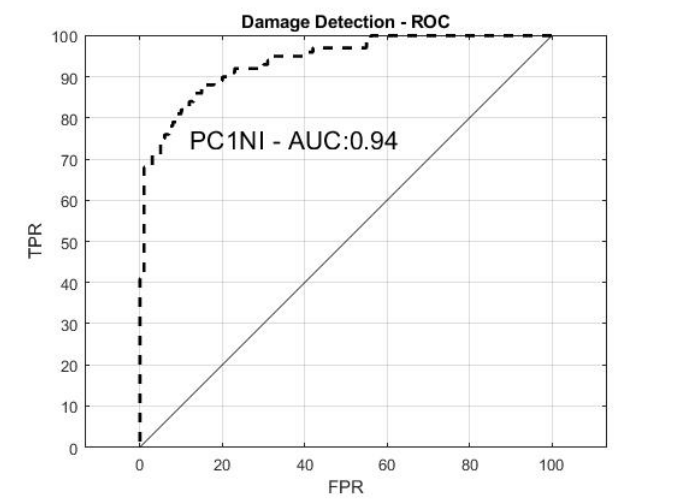
Figure 11. Evaluation of the performance of the TCM data analysis through the ROC curve, repre- senting the False Positive Rate (FPR) vs. the True Positive Rate